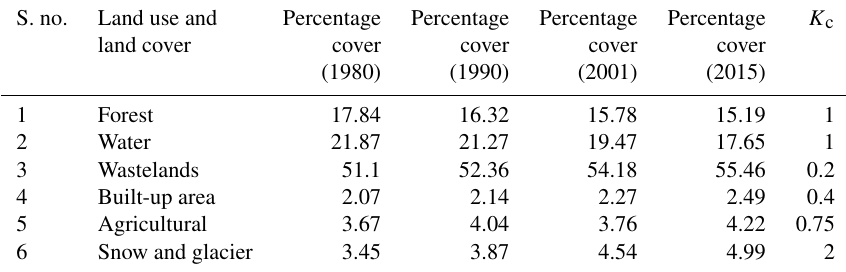
Table 1. Value of K c corresponding to the classes of land use and land cover.